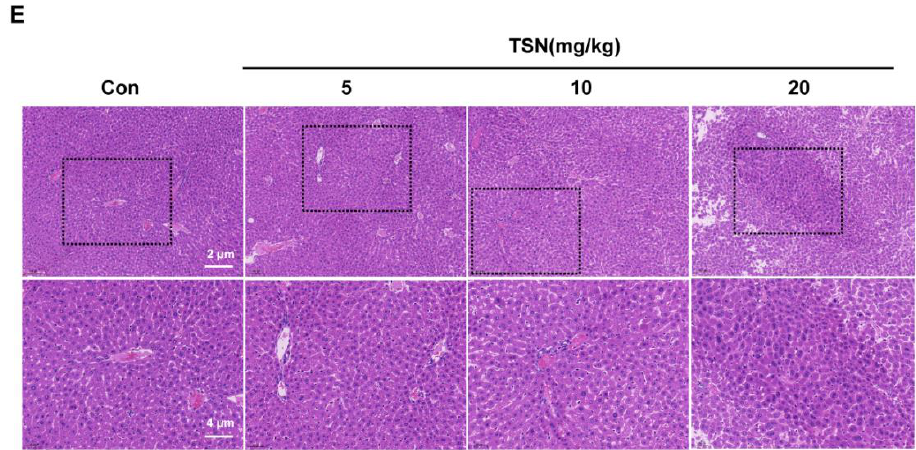
Figure 7. TSN induced liver injury in Balb/c mice. Balb/c mice were intraperitoneally administered TSN at different doses (5, 10, 20 mg/kg) or by vehicle for 24 h. Serum and liver tissue were harvested after TSN treatment. ( A ) Liver index were calculated from vehicle and TSN-treated groups. The effects of TSN on the levels of ALT ( B ), AST ( C ), and LDH ( D ) in serum were measured. ( E ) The effects of TSN on the histological changes in mice liver tissues are indicated by H&E staining. Scale bar: 2 μm (above) and 4 μm (below). Data are presented as the mean ± SD * p < 0.05, ** p < 0.01 versus vehicle, n = 9.